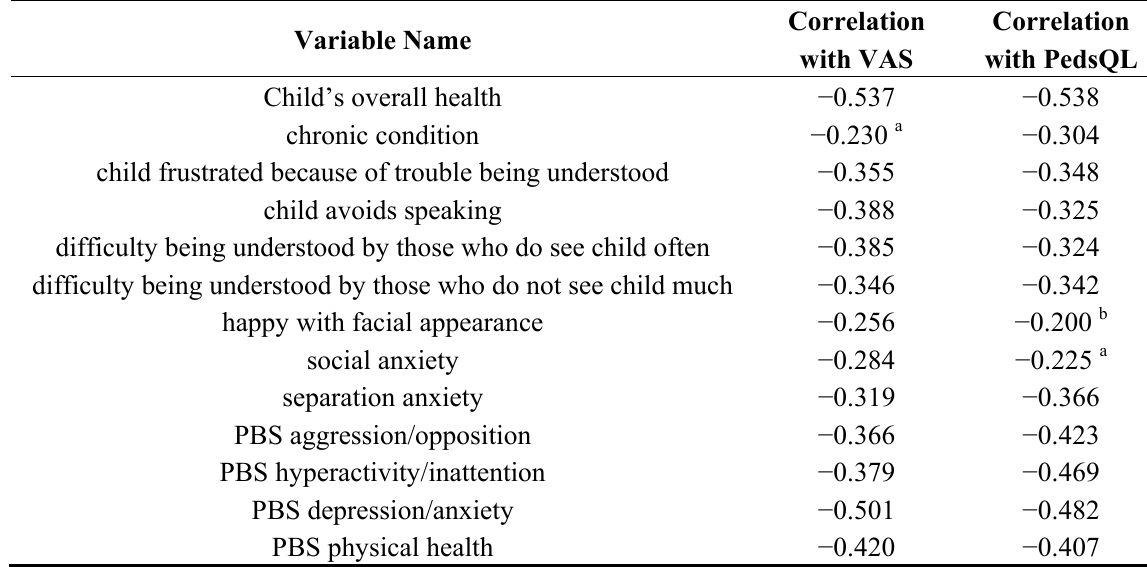
Table 2. Correlations of VAS and PedsQL TM with selected measures of child health and